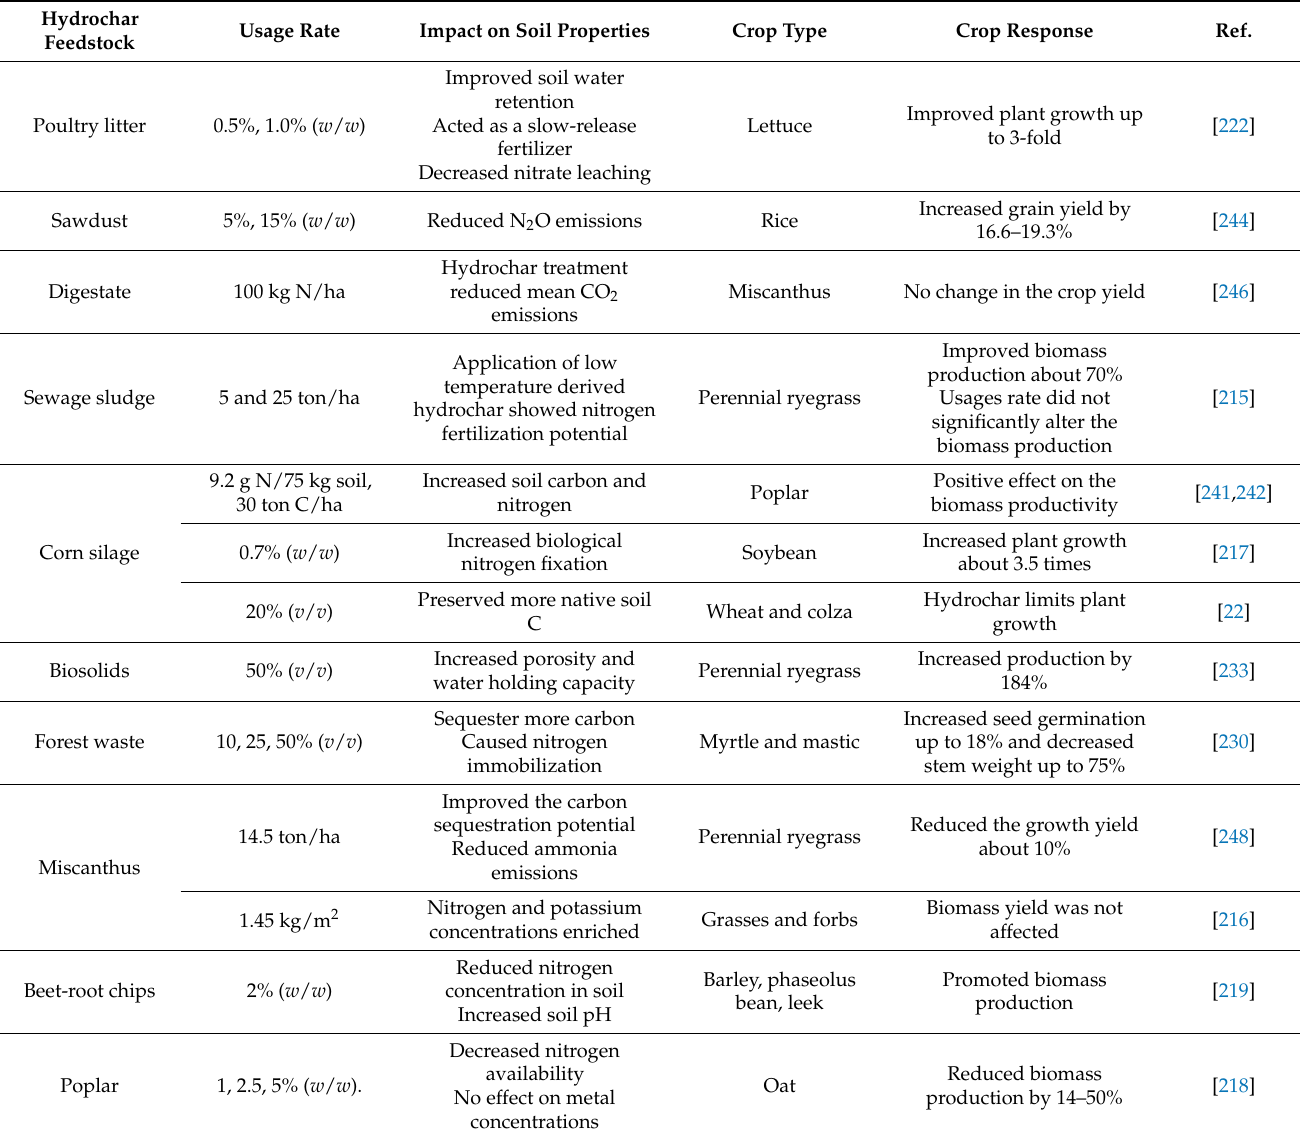
Table 7. Impact on solid properties and plant growth after applying the hydrohcar as soil